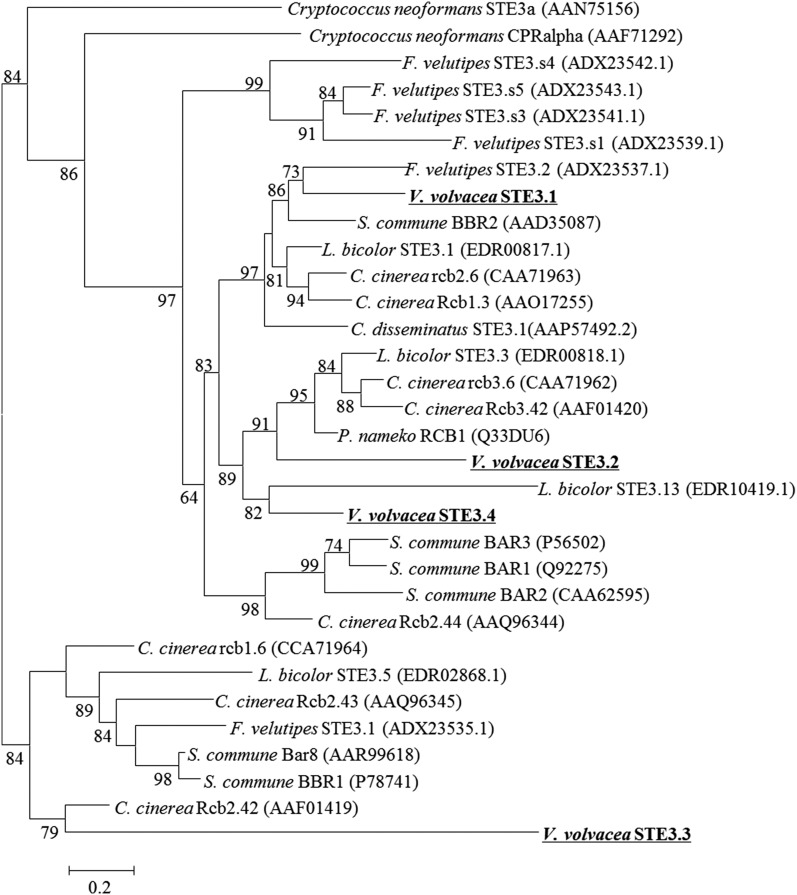
Phylogenetic tree depicting the relationship between pheromone receptor and pheromone receptor-like proteins from bipolar (Coprinellus disseminatus and P. nameko) and tetrapolar (the others) homobasidiomycetes, with that of V. volvacea. Cryptococcus neoformans was used as out-group.